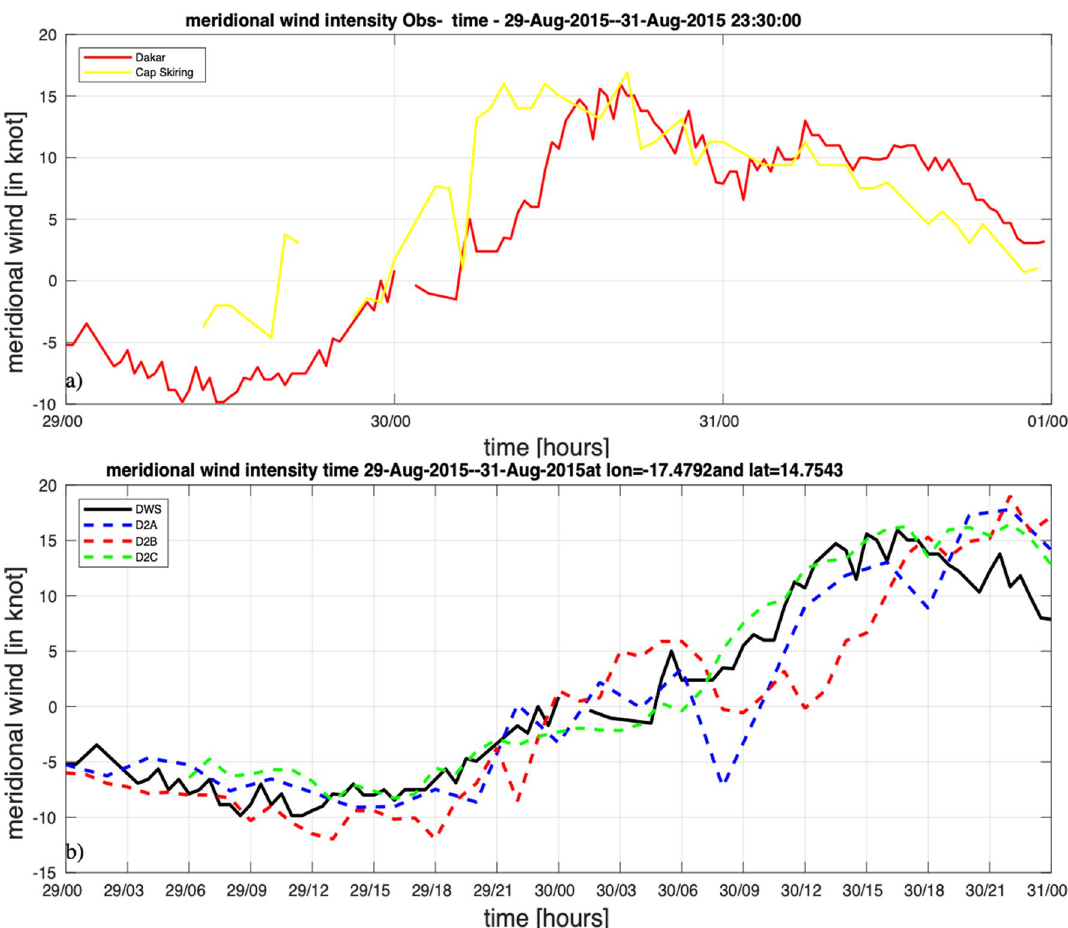
as in a blue dashed line for simulation 2A, red dashed line for 2B and green dashed line for 2C. The solid black line represents the observed meridional wind at